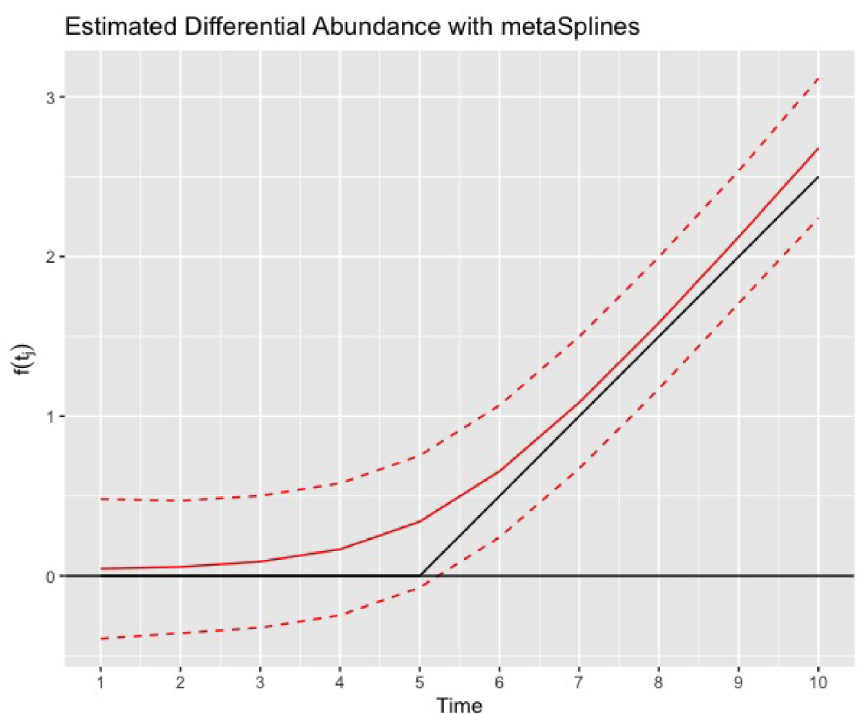
Figure 7. Comparison of the estimated functional form for the metaSplines method, in red, to the truth, in black.